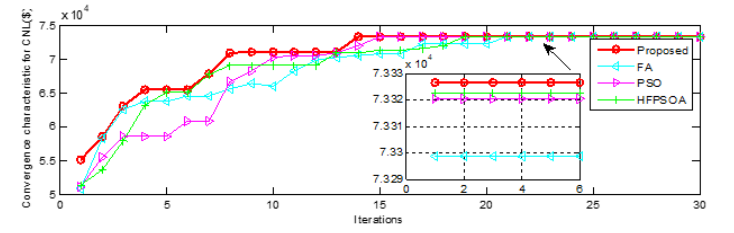
Figure 10. The convergence characteristic for the